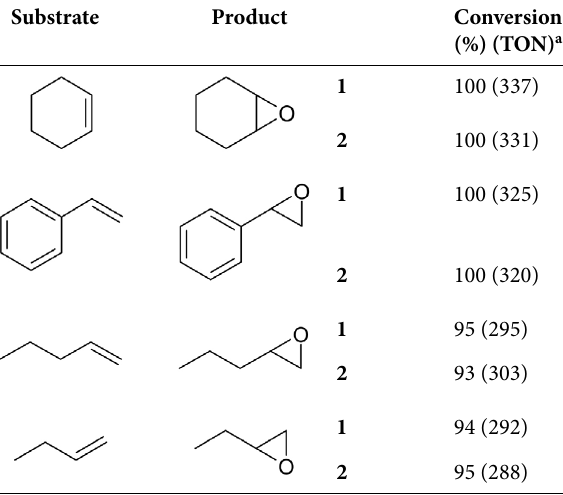
Table 4. The catalytic oxidation results Substrate Product